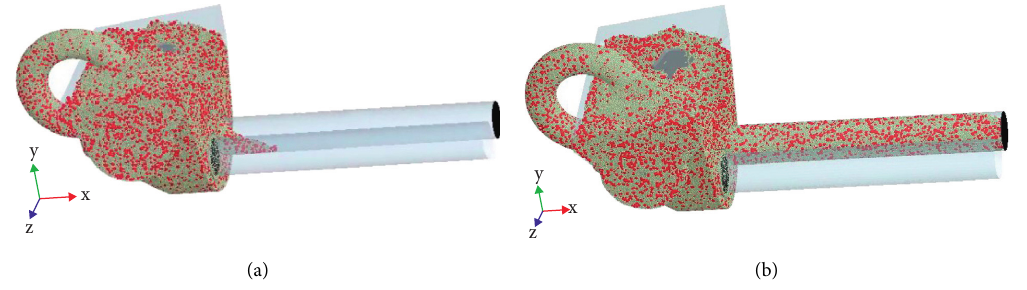
Figure 9: The numerical simulation results when k � 0 (a) and k � 66